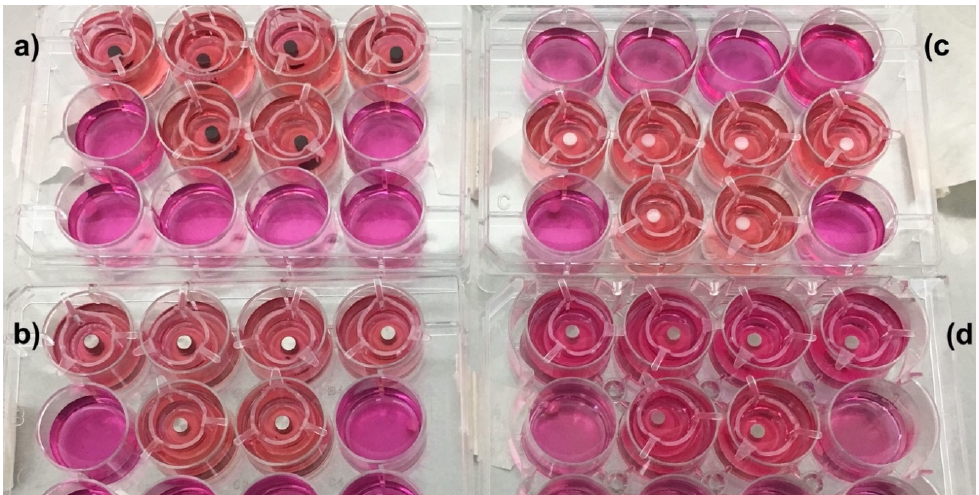
Figure 1. The engineered mucosa models with inserted ( a ) titanium–zirconium alloy with sandblasting and acid etching (TiZr-SLA), ( b ) machined (M) TiZr (TiZr-M), ( c ) zirconia (ZrO 2 )-M, and ( d ) polyether ether ketone (PEEK)-M